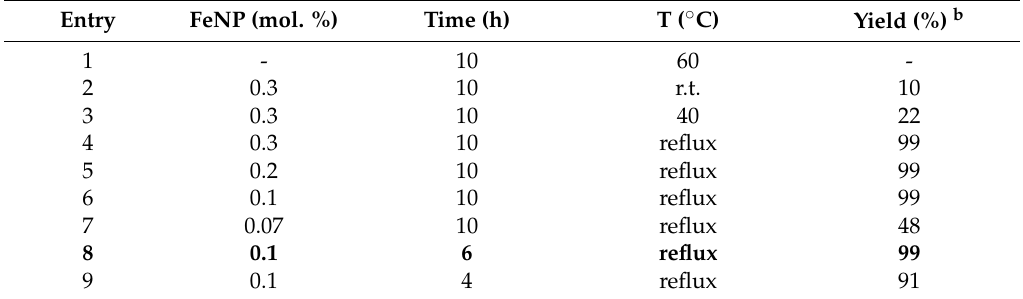
Table 1. Screening of reaction conditions in the esterification of benzoic acid with methanol a . Entry FeNP (mol. %)